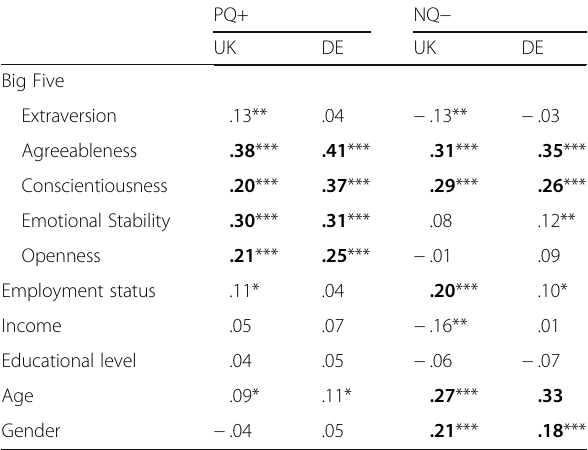
Table 4 Correlations of the KSE-G with relevant